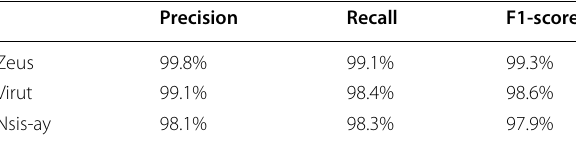
Table 4 Malicious traffic identification by HexCNN-1D